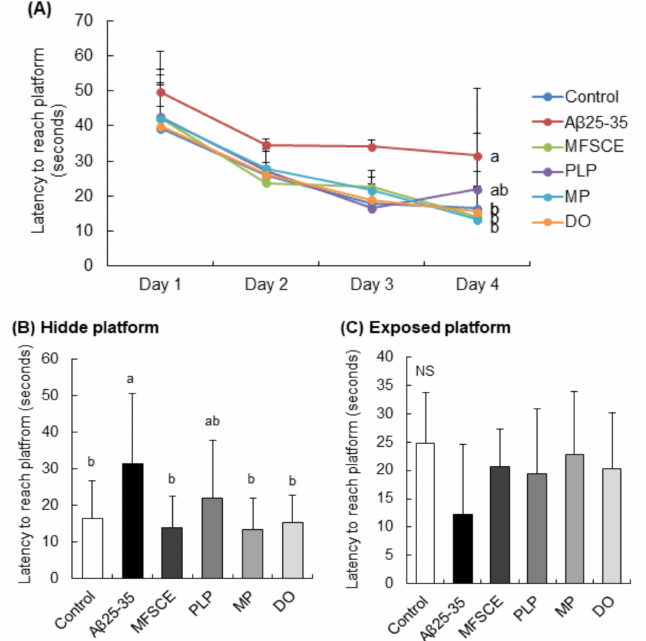
Figure 4. Effect of MFSCE on the spatial memory ability in the Morris water maze test in A β 25–35 - injected mice. ( A ) Effects of MFSCE on the escape latency to the platform during 4 days in the Morris water maze test in A β 25 − 35 -injected mice. ( B ) Effects of MFSCE on latency to reach the hidden platform. ( C ) Effects of MFSCE on the latency to reach the exposed platform. Data are expressed as mean ± SD ( n = 10). a,b Means with different letters are significantly different ( p < 0.05) from each other. NS: no significance. Control group: 0.9% NaCl saline i.c.v. + 0.9% NaCl saline i.p.; A β 25–35